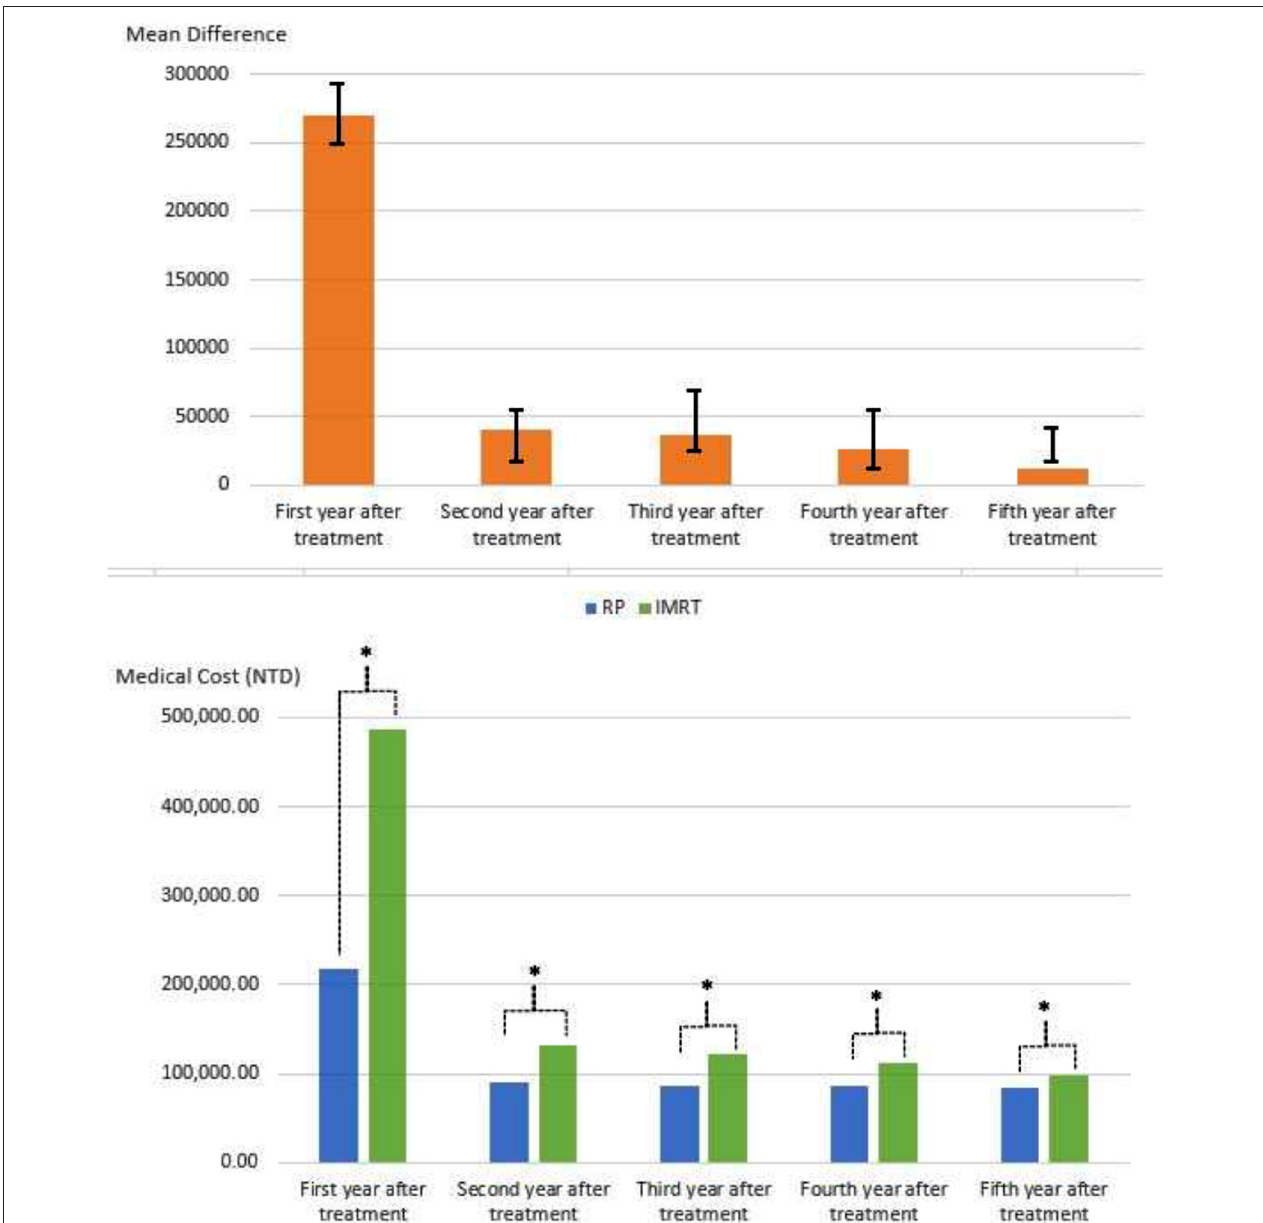
FIGURE 1 | The bar plots of medical costs trends by time stratified by RP and IMRT. RP, radical prostatectomy; IMRT, intensity-modulated radiation therapy; NTD, new Taiwan dollars. * P <